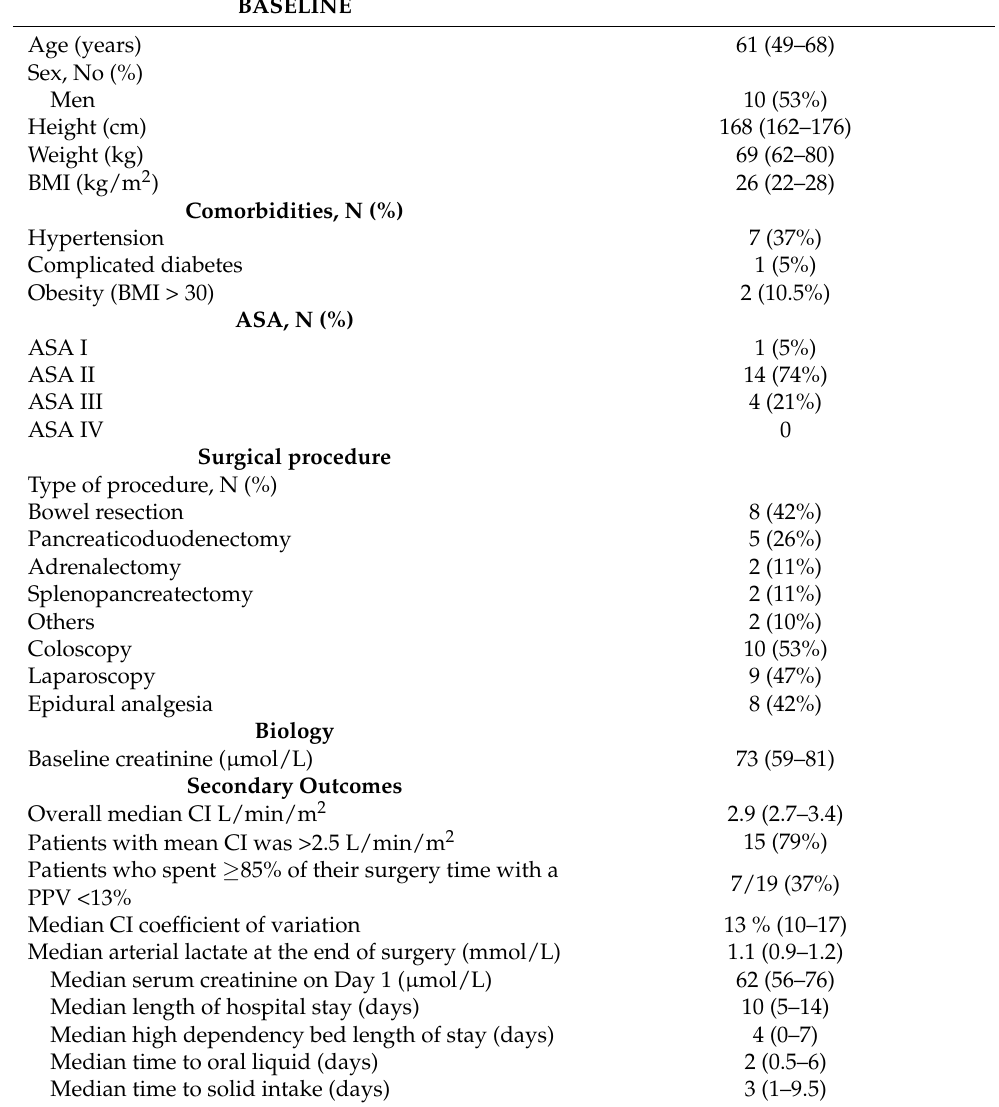
Table 1. Patient characteristics and secondary